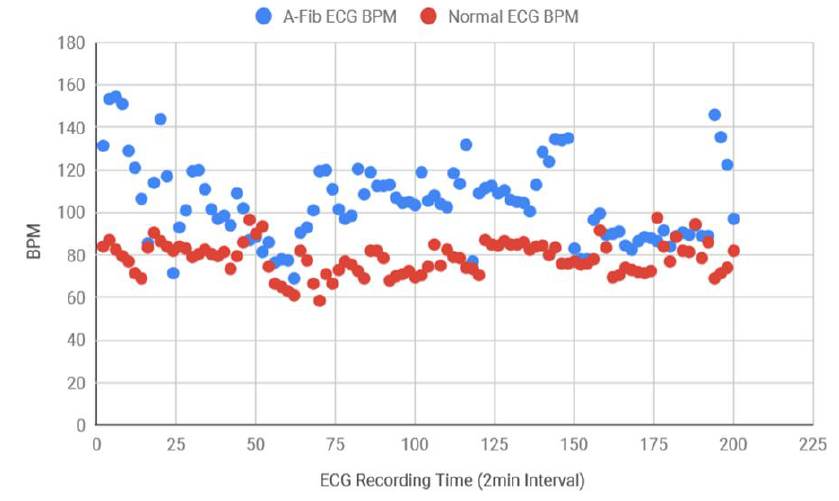
Figure 14. Variance in BPM data collected from multiple subjects.